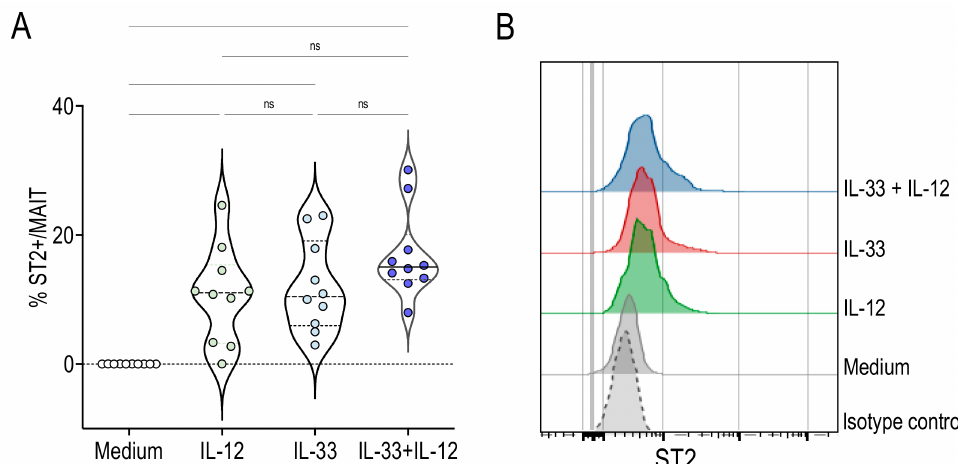
Figure 4. MAIT cells express ST2 following IL-33 or IL-12 stimulation. ( A ) Percentage of ST2 + cells among gated MAIT cells stimulated for 24 h with IL-12, IL-33 and IL-33 + IL-12. Bars indicate medians and quartiles. Data were acquired from five donors in two experiments. ( B ) Histograms on the right are representative of ST2 expression among gated MAIT